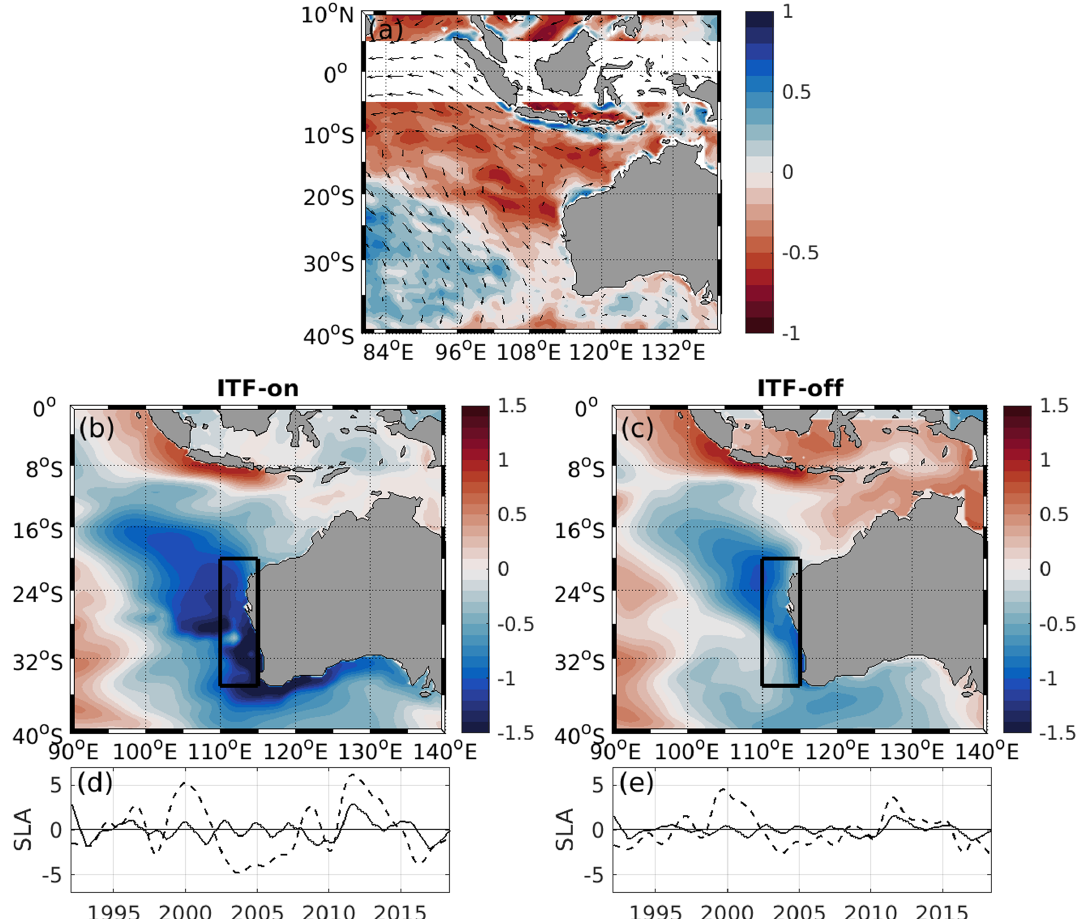
Figure 7. (a) Regression of Ekman pumping (color shading) and wind stress (arrows) on MEI, expressed in meters per month per standard deviation of change in the index. Negative (positive) Ekman pumping anomalies associated with the upper-ocean warming (cooling) are shown by red (blue) color. Regression of monthly SLA on the normalized meridional surface wind stress from 1995 to 2018 averaged in the black box for the ITF-on (b) and ITF-off (c) simulations, expressed in centimeter per 1SD of change of the meridional surface wind stress (1SD = 0 . 045Nm − 2 ). (d, e) Time evolution of the reconstructed SLA (solid black line) and modeled SLA (dashed black line) associated with the regression from the ITF-on and ITF-off